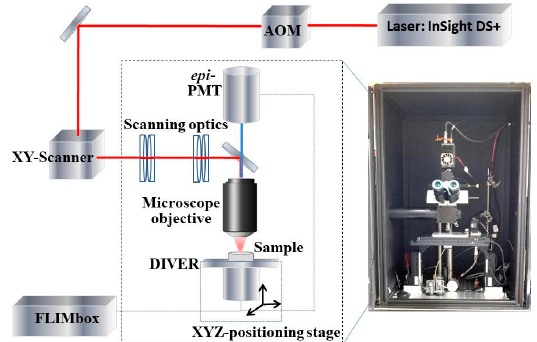
Figure 1. Schematics of the DIVER (Deep Imaging Via Emission Recovery) imaging system.